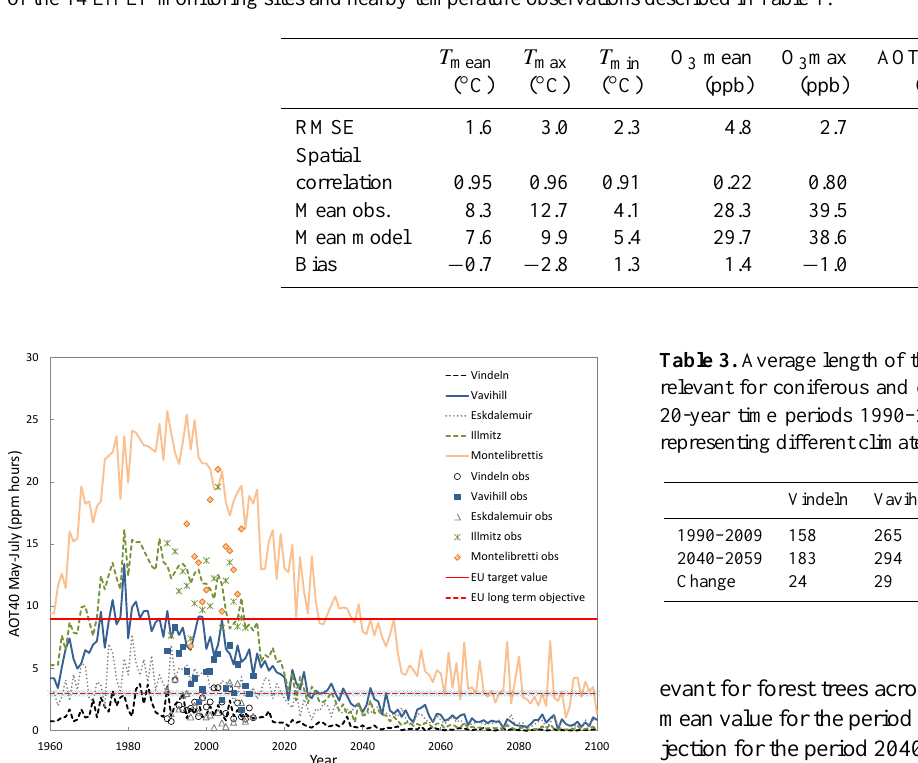
Table 2. Comparison between observations and simulations of daily average, maximum and minimum temperature ( T in ◦ C) over the whole year, daily average and maximum O 3 (ppbv) at 3 m above ground over the whole year and AOT40 accumulated from May to July (ppb-hours) of the 14 EMEP monitoring sites and nearby temperature observations described in Table 1.